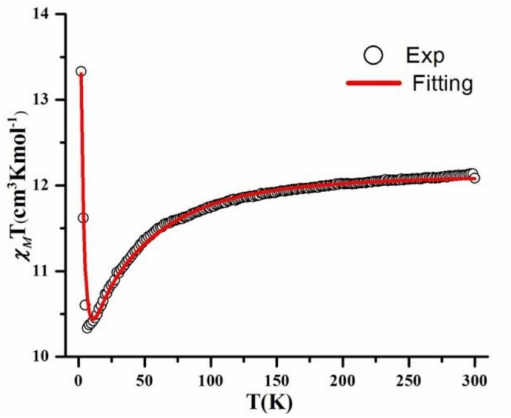
Figure 3. χ M T versus T plots at 1 KOe for complex 1